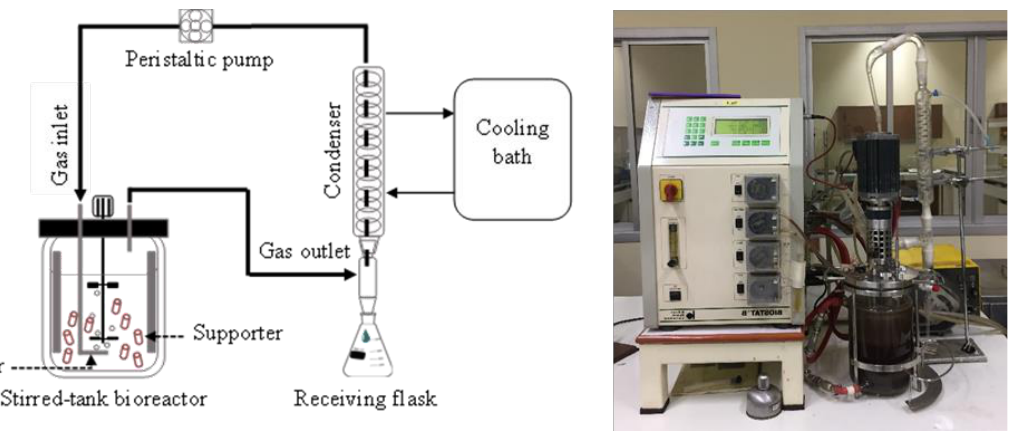
Figure 1. Diagram of butanol production in a stirred tank bioreactor integrated with a gas stripping system.